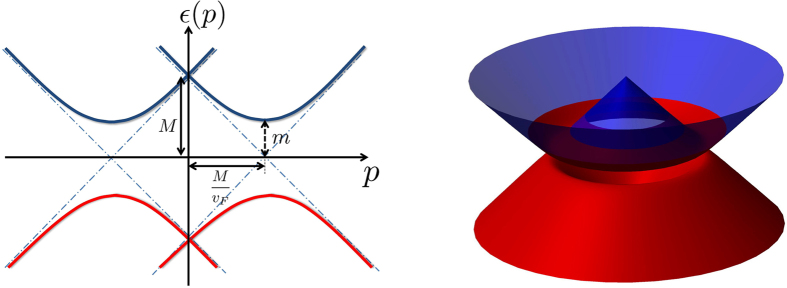
Left) The bandstructure of a Dirac ring system ±ε(p) given by Eq. 4, with asymptotic canonical velocity (slope) given by .Right) 3D view of the same band structure, with the axis of rotation the energy axis and the plane of rotation the px, py plane. The occupied (red) band is separated from the partially occupied (blue) band by a mass gap 2m. They can be obtained by gapping out two intersecting Dirac cone with energy difference of 2M. A ring of filled states (red) at chemical potential μ > m lies in the ring of minima on the valence (blue) band.